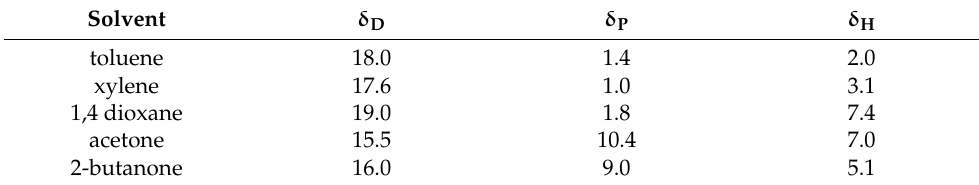
Table 4. Hansen solubility parameters for the indicated solvents